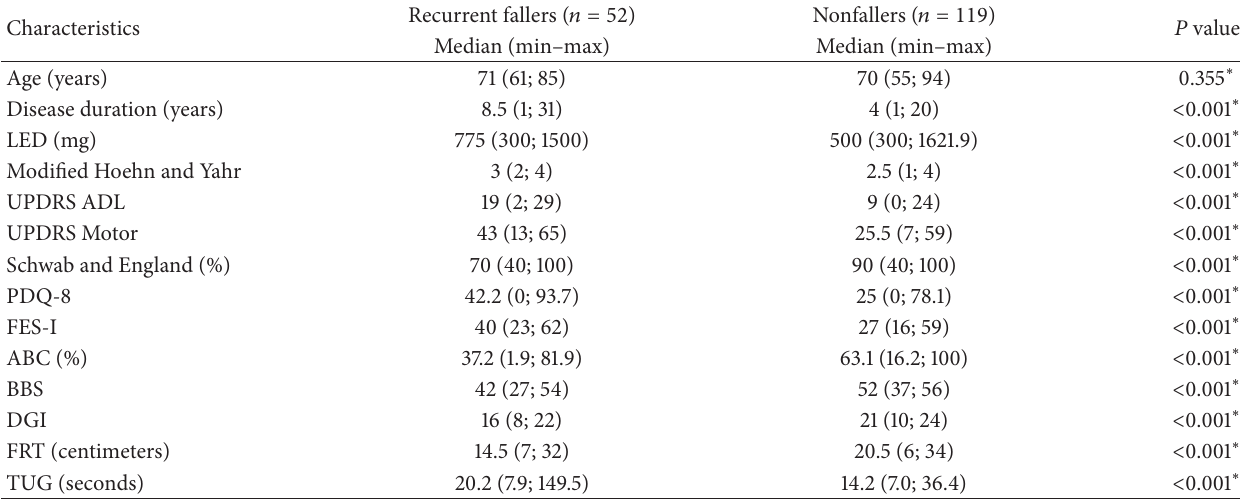
Table 1: Demographic, disease-specific characteristics and balance-related measures of the sample and comparison between recurrent fallers and nonfallers.